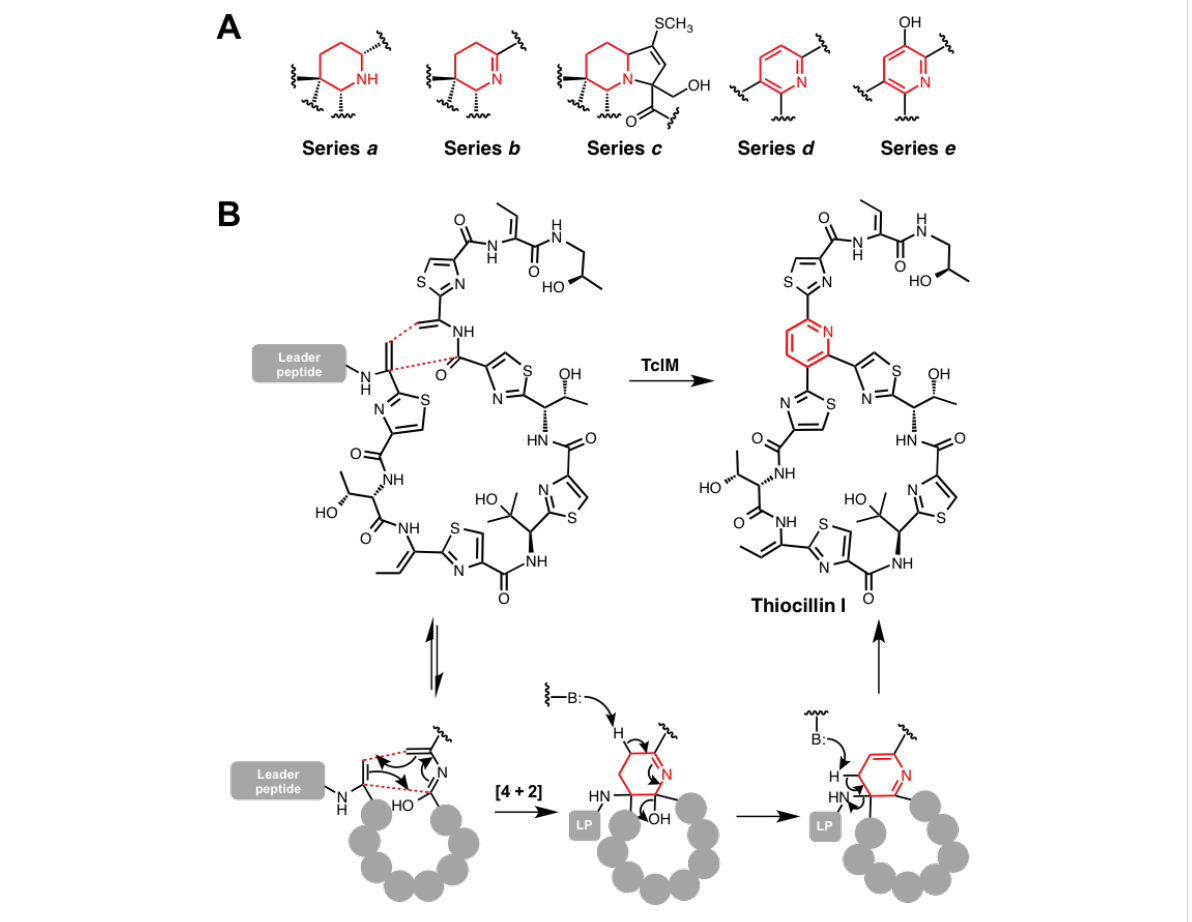
Figure 6: Cyclisation in the biosynthesis of thiopeptides. A) Mechanism of TclM-catalysed heterocyclisation in the biosynthesis of thiocillin I. B) An overview of the various 6-membered nitrogen-containing heterocycles that are found in thiopeptides.